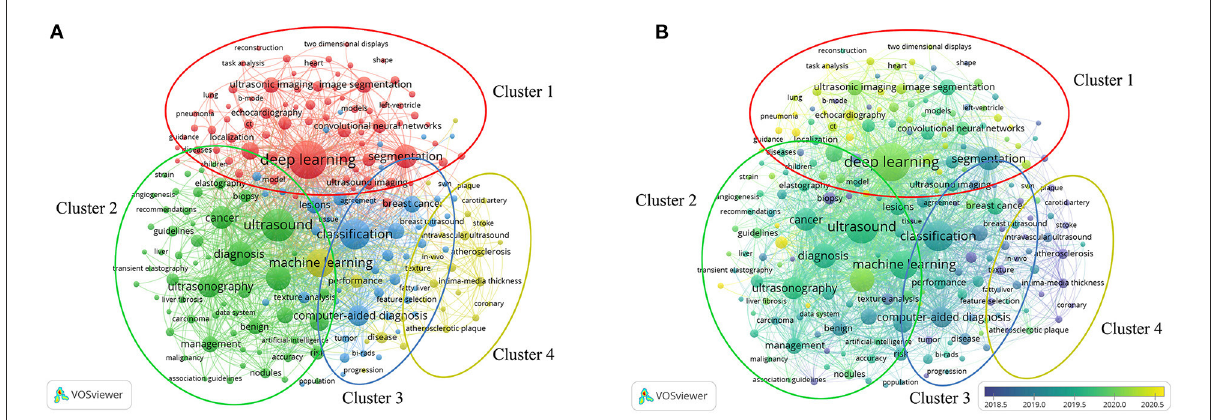
FIGURE6 Co-occurrence analysis of all keywords in publications on the application of artificial intelligence in ultrasound. (A) Mapping the keywords of artificial intelligence applied in the field of ultrasound. The size of the circle indicates how often the keyword appears. (B) Present the distribution of keywords according to the average time of occurrence. The blue means earlier, and yellow means